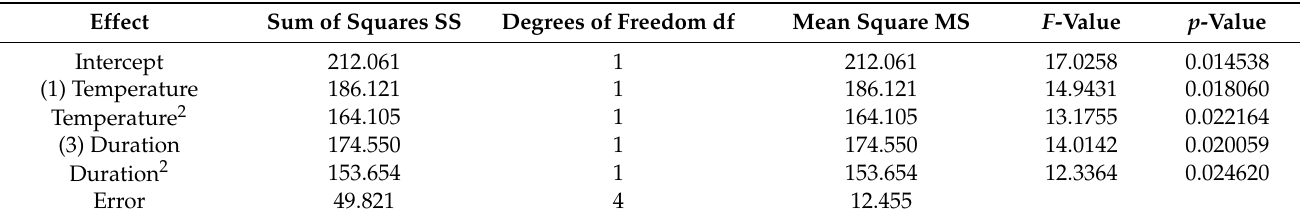
Table 10. Analysis of variance for the regression model of the thickness of the toothed part of the boride layer.